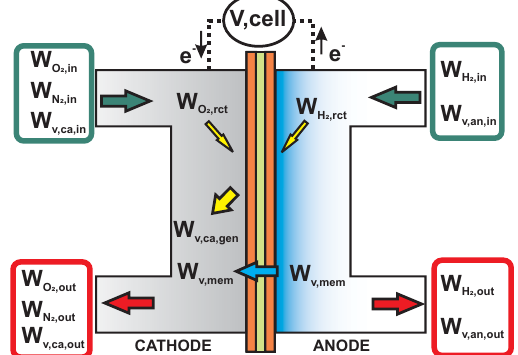
Figure 5. Mass flows considered in the single cell of the stack. Total stack voltage v stack = n × v cell , where n is several cells in the